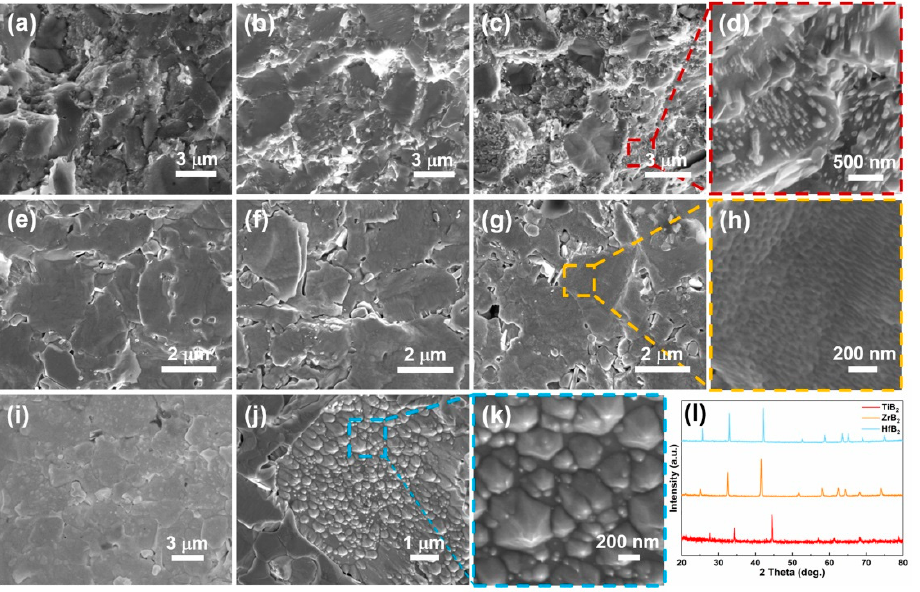
Figure 5. The SEM images of TiB 2 after HCl etched ( a ) 12 h, ( b ) 24 h, ( c ) 48 h, ( d ) the magnified images of the red dotted box in ( c ), the SEM images of ZrB 2 after HCl etched ( e ) 2 h, ( f ) 4 h, ( g ) 6 h, ( h ) the magnified images of the yellow dotted box in ( g ), the SEM images of HfB 2 after HCl etched ( i ) 2 h, ( j ) 4 h, ( k ) the magnified images of the light blue dotted box in ( j ), ( l ) the XRD of TiB 2 , ZrB 2 and HfB 2 after HCl etched.